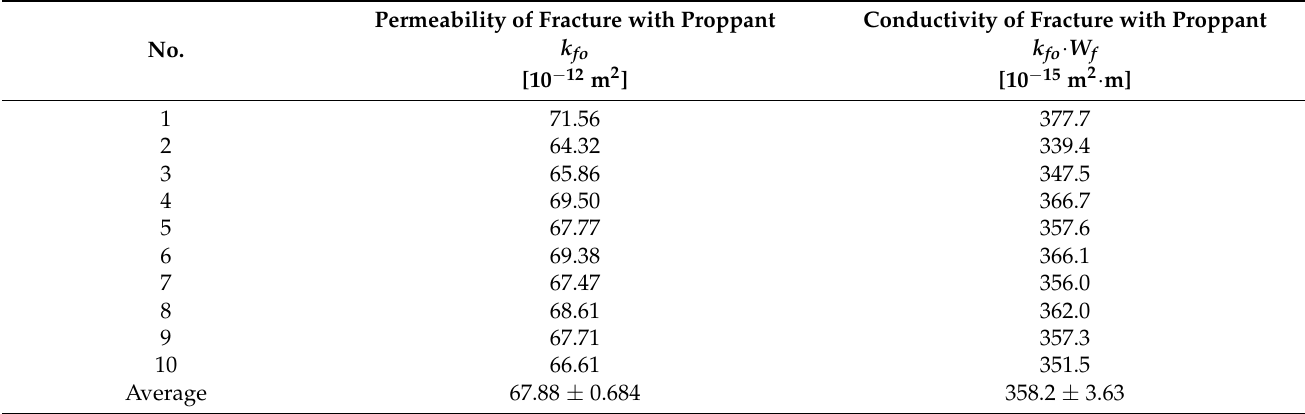
Table 6. The measurement results for the determination of the original conductivity and permeability of the fracture filled with quartz sand 20/40, without damaging it with fluid, at 60 ◦ C; compressing stress 27.6 MPa.